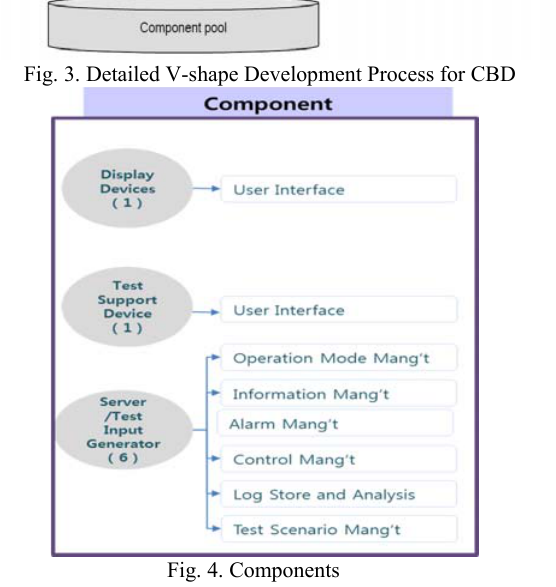
Fig. 3. Detailed V-shape Development Process for CBD